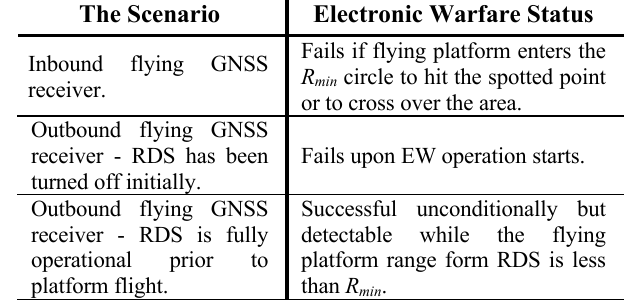
Tab. 3. Final results of spoofing a flying